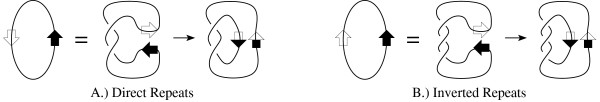
Cre recombination. A.) If the Cre binding sites are directly repeated, then Cre recombination results in a link. B.) If the Cre binding sites are inversely repeated, then Cre recombination can knot circular DNA.